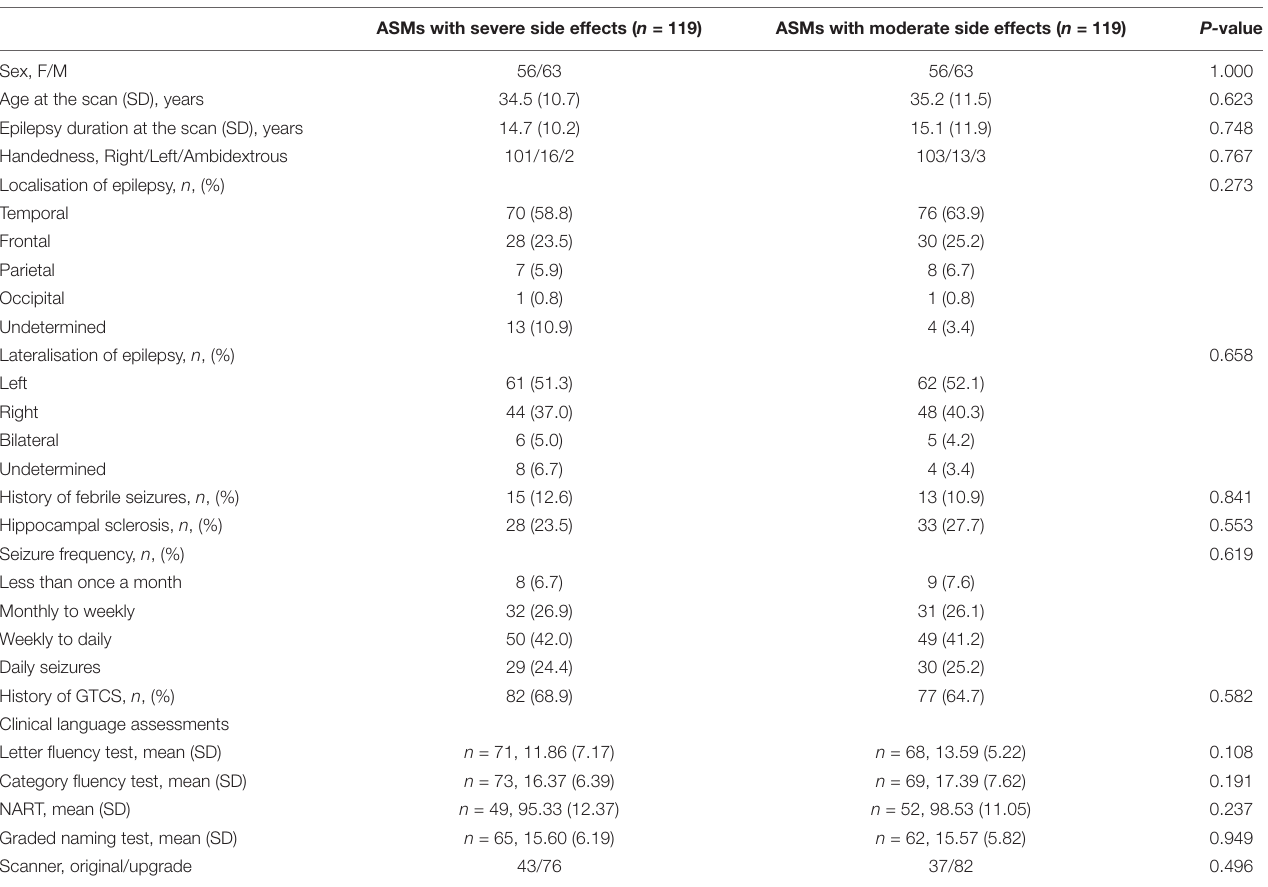
TABLE 2 | Demographic and clinical features between ASMs with moderate and severe side